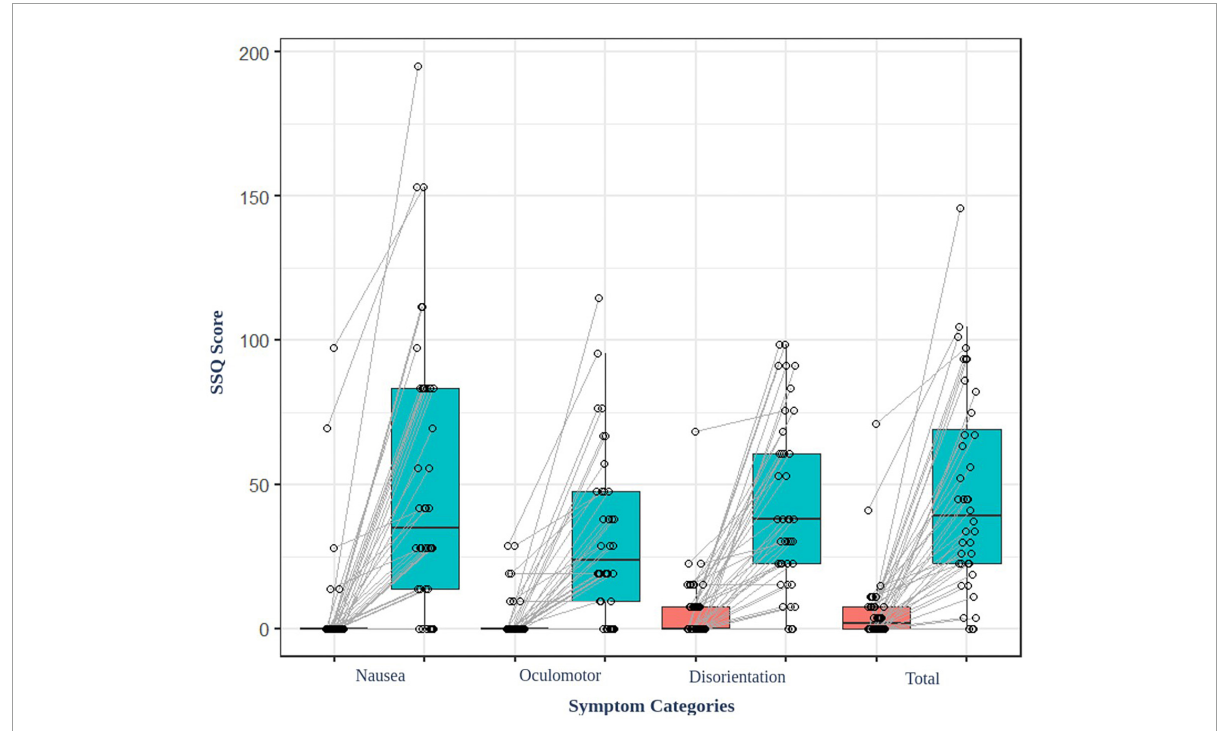
FIGURE2 SSQ score of the participant before and after watching the VR video content. All the participants felt cybersickness ( p < 0.001).